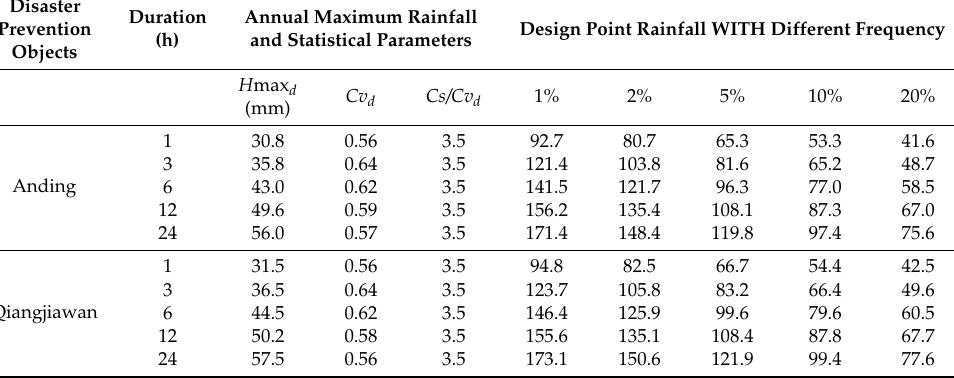
Figure 8. Isogram of the coefficient of variation of max point rainfall ( Cv d ) of Zichang County. Cv d is the coefficient of variation with different durations. Table 3. Design point rainfall calculation results with different frequency.